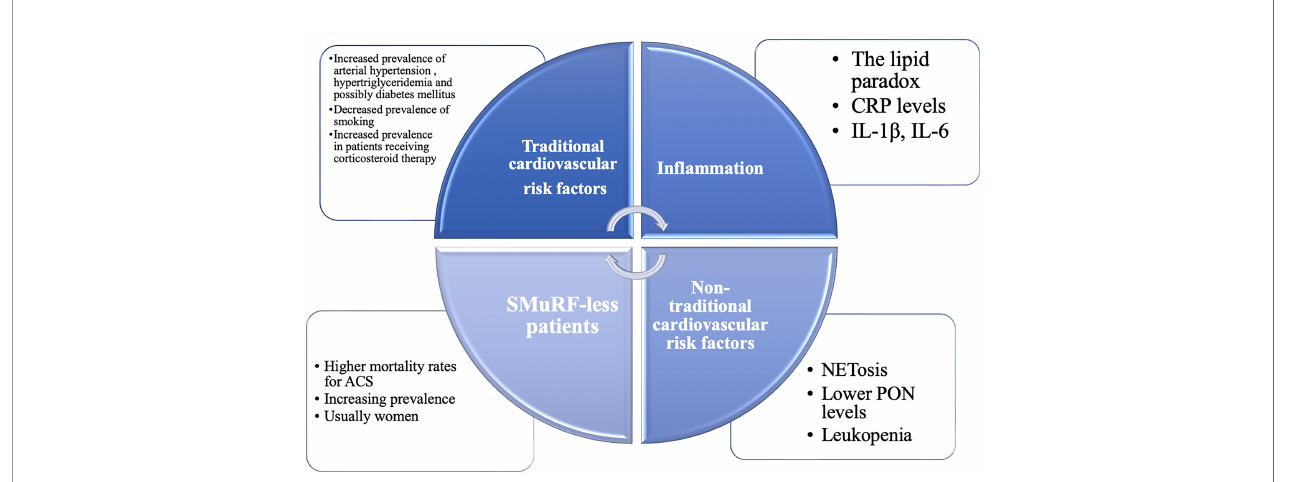
FIGURE 1 | The continuum of cardiovascular risk factors in primary Sjögren ’ s Syndrome (pSS). Traditional and non-traditional cardiovascular risk factors are inextricably intertwined in this heterogenous population. CRP, C reactive protein; GC, glucocorticoids; HCQ, hydroxychloroquine; IL, interleukin; NETosis, formation of neutrophil extracellular traps; NSAIDs, non-steroidal anti-in fl ammatory drugs; PON, paraoxonase-1; SMuRF-less, without standard modi fi able cardiovascular risk